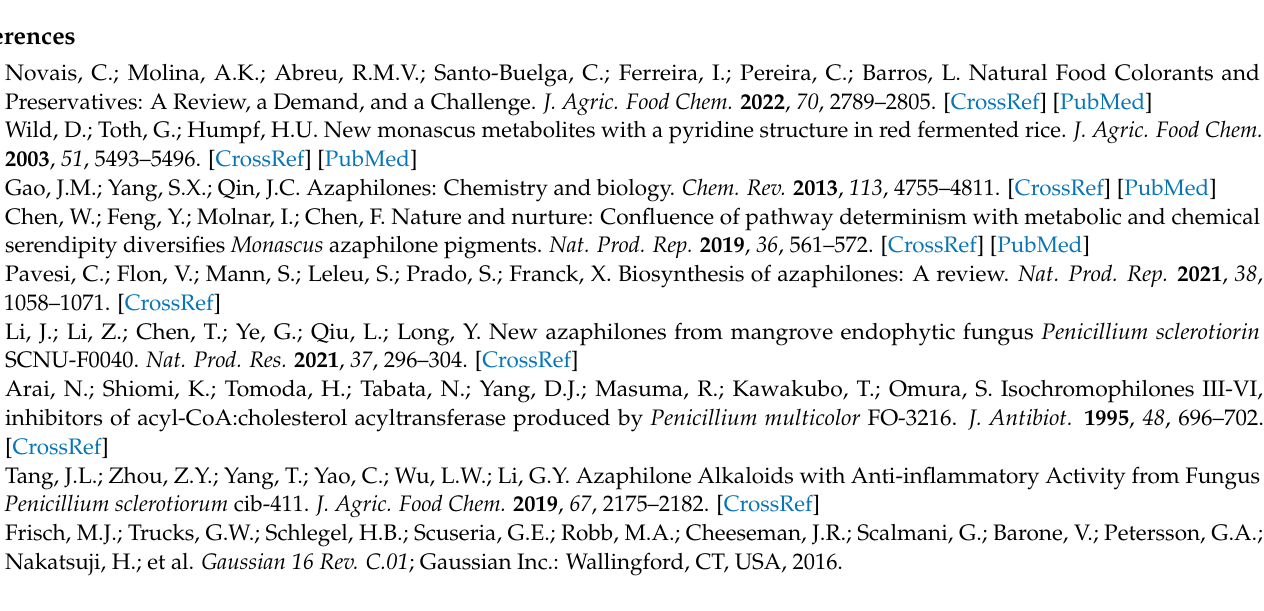
Figure S23: Comparison of the experimental ECD spectrum of 1 and calculated ECD spectrum for the (2 R , 7 S , 7 ”S , 13 S , 13 S” ) stereoisomer. Figure S24 Absorption and emission spectra of penazaphilone